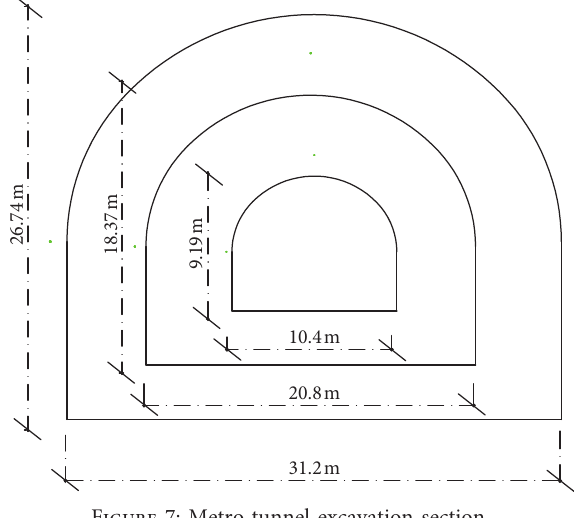
Figure 7: Metro tunnel excavation section.